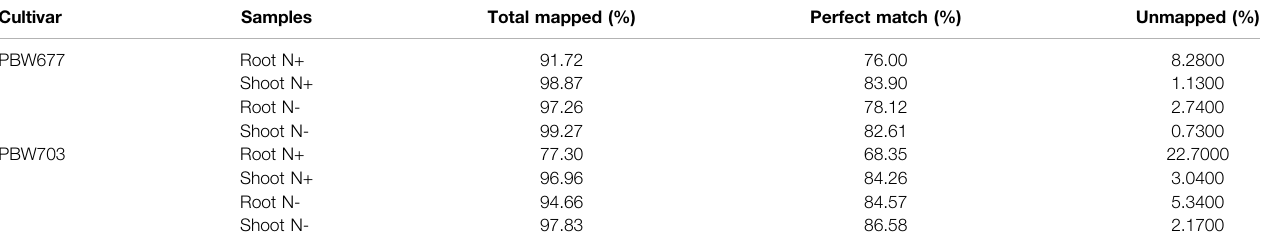
TABLE 2 | Mapping statistics of the transcriptomics data. Cultivar